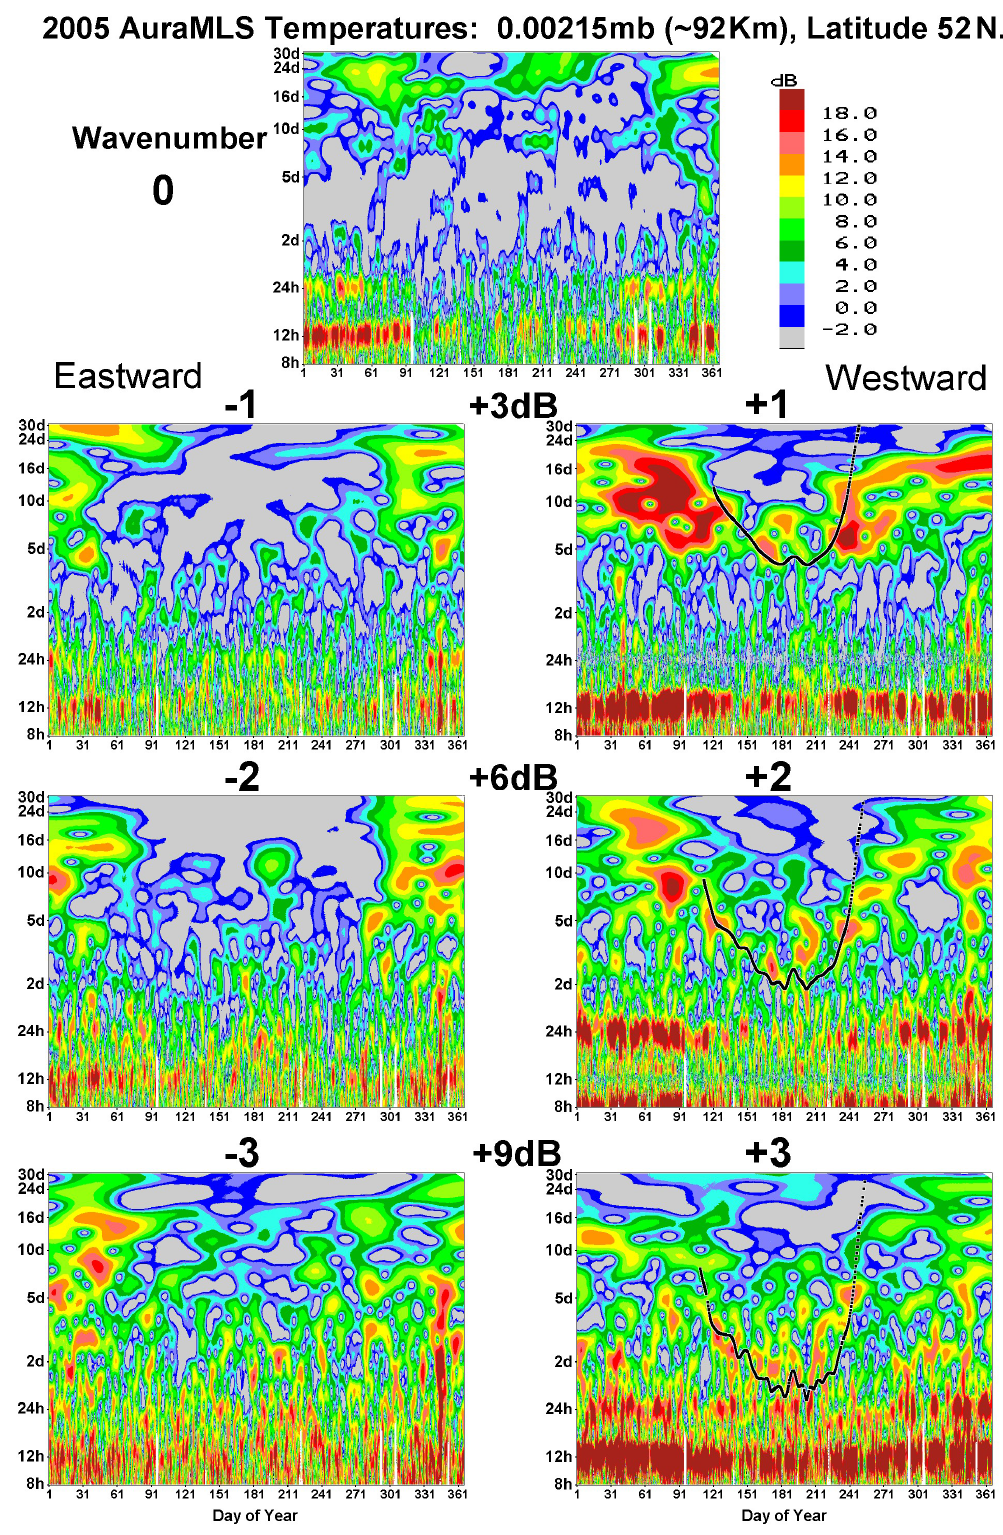
Fig. 1. 2005 Aura MLS temperature wavelets for wavenumbers 0 to ± 3. The sequences are 6 periods long, windowed with a Gaussian. Some clipping of strong signals (e.g. at 12h) has been allowed. The “gain” of the plot is increased with wave number. The overplotted line is a phase speed limit estimated from radar data. (see